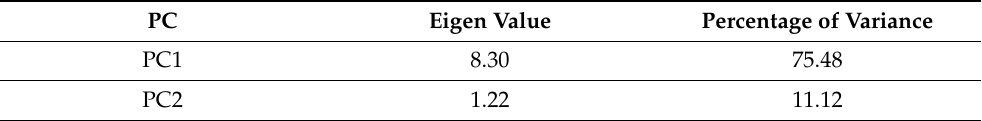
Table 5. Eigen values of percentage of variance of the principal components of production parameter.